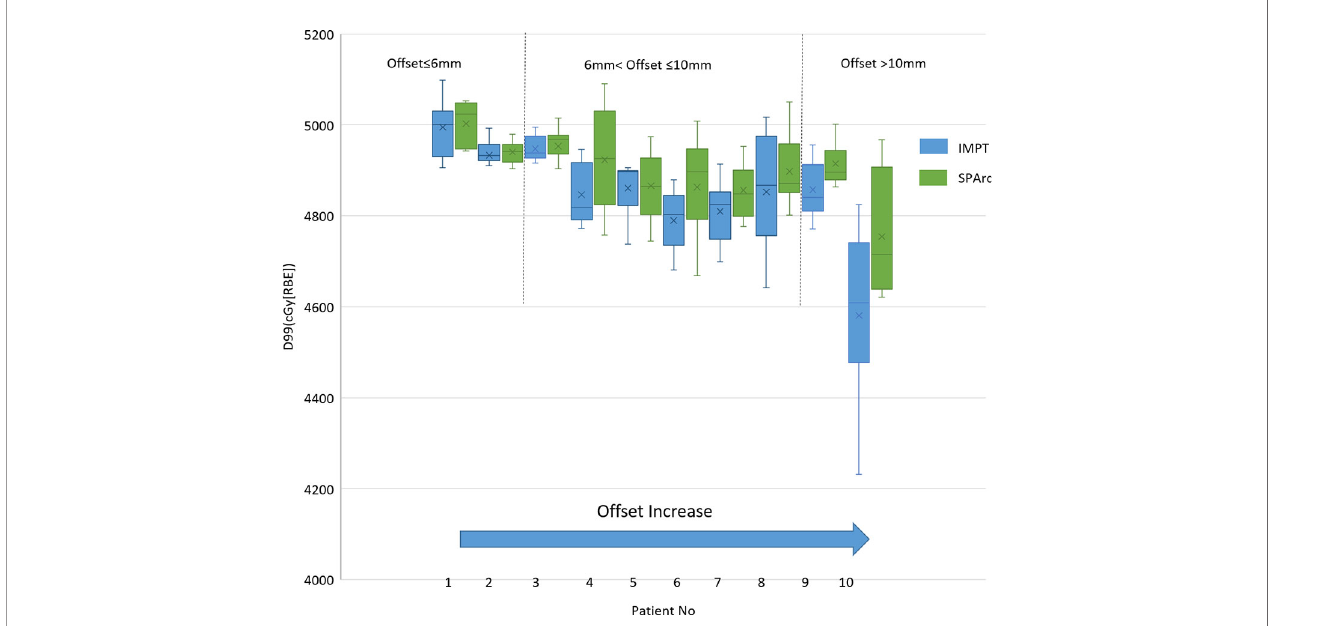
FIGURE 4 | Single fraction dynamic dose for target coverage D99 for ten